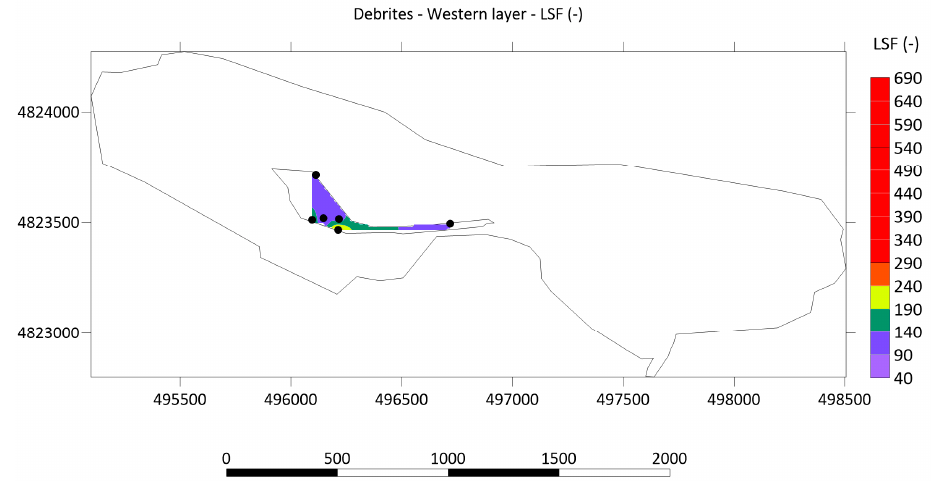
Processes 2022 , 10 , x FOR PEER REVIEW 17 of 19 Figure 16. Map of SiO 2 (%) in unit (7), western layer (boreholes are black dots). Figure 16 . Map of SiO 2 (%) in unit (7), western layer (boreholes are black dots).